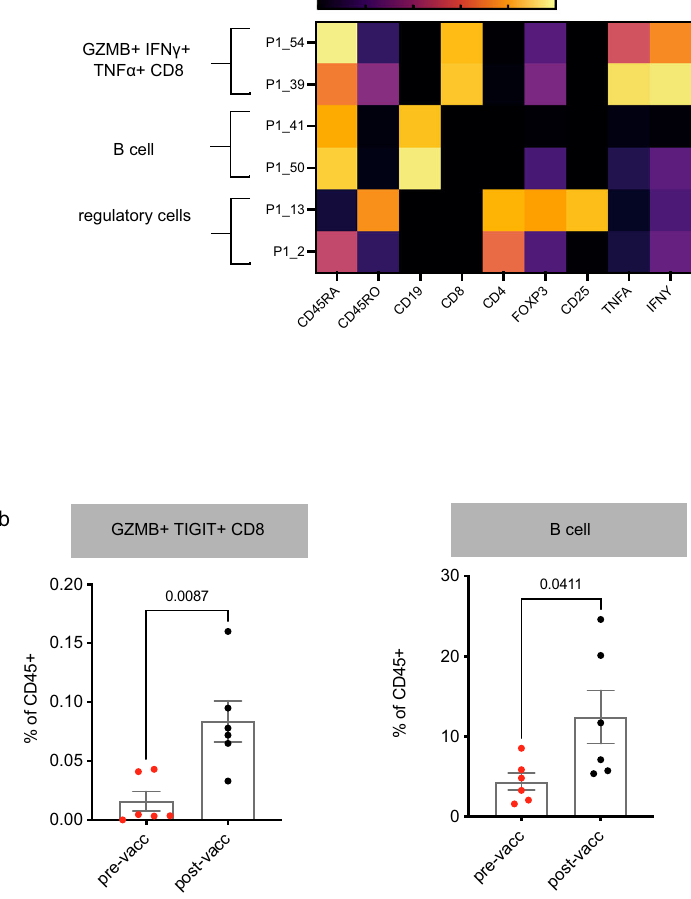
( a ) Heatmap represents the scaled arcsin median expression of each marker. Mann – Whitney U tests (two-tailed) were performed to compare between groups ( n =6 patients). Error bars indicate SE of the mean. Some samples were excluded from supervised analyses due to insuf fi cient cell numbers. Source data are pro- vided as a Source Data fi